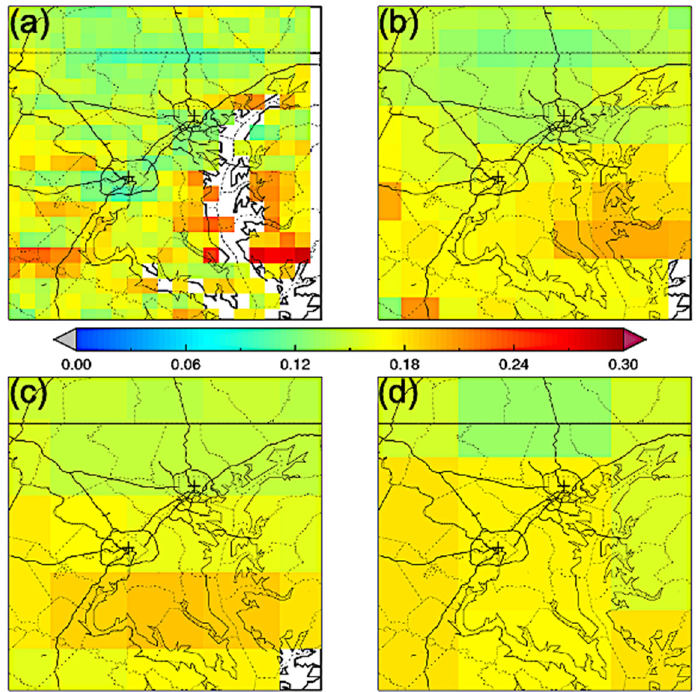
Figure 9. Application of HRG AODs to access the spatial gradient in aerosols at the urban scale. The maps show HRG AODs at original resolution (0.1 × 0.1) ( a ) and resampled at reduced resolution of 0.25 ( b ), 0.5 ( c ), and 1 ( d ) degree spatial resolution. The data are averaged for July 2010. The spatial resolution becomes very critical in evaluating small spatial scale gradients, and current operational coarse resolution data may not be adequate for such analysis.